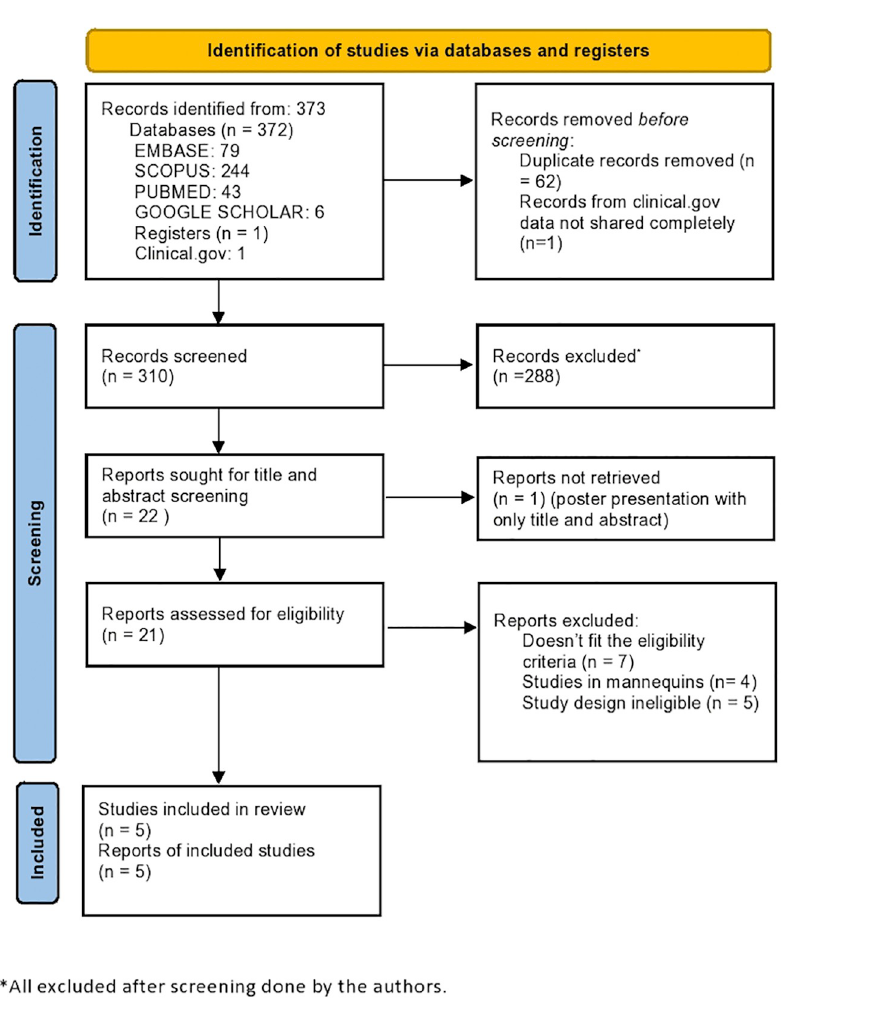
Fig 1. PRISMA flowchart of the included